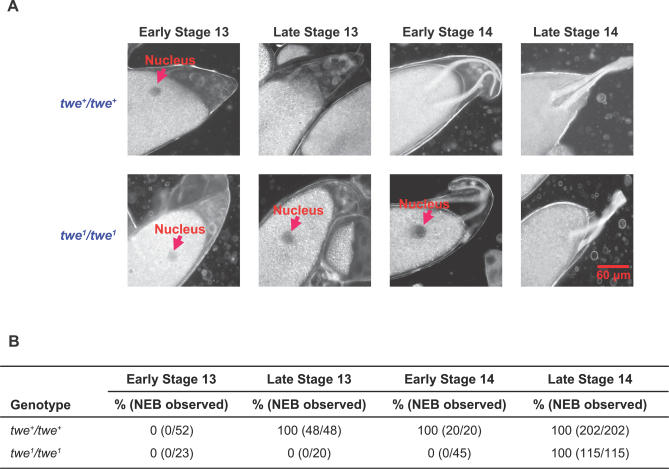
Mutants in the Drosophila cdc25 Homolog twine Fail to Undergo NEB in Stage 13(A) Representative examples of NEB in stage 13 and 14 egg chambers for wild-type (w1118) and twine (twe1 ) homozygotes. The nucleus is present (seen as a dark mass by phase contrast microscopy) at early stage 13 but not at late stage 13 and stage 14 in wild type. twe1 homozygotes show delayed NEB and that the nucleus is still present until early stage 14. Scale, 60 μm.(B) Summary of NEB in stage 13 and stage 14 egg chambers for wild-type (w1118) and twe1 homozygotes (twe1/ twe1).